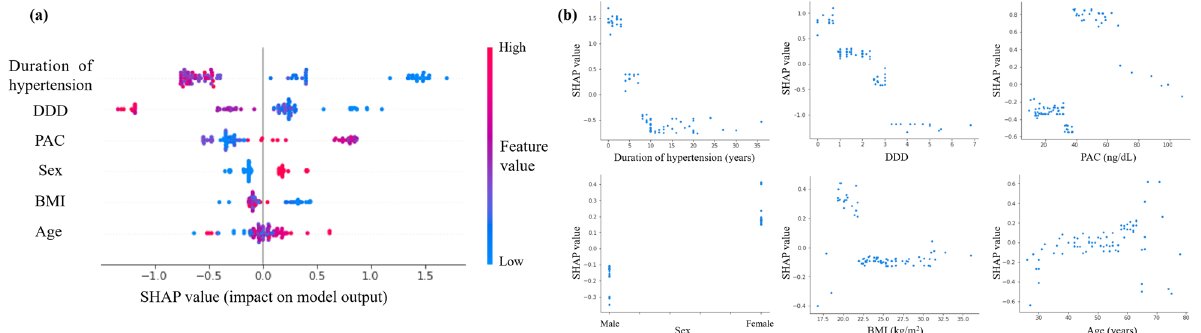
Figure 4. SHAP summary plot and dependence plots. (a) SHAP summary plot of six features in the model. Features were sorted in descending order by SHAP values. SHAP values for each feature were calculated for each patient-derived model, which is represented by a single dot. Dots were colored based on the underlying feature’s value. For the features of sex, the red dots indicated female and the blue dots indicated male. (b) SHAP dependence plots for each feature in the model. SHAP values for specific features exceed zero, representing an increased probability of complete clinical